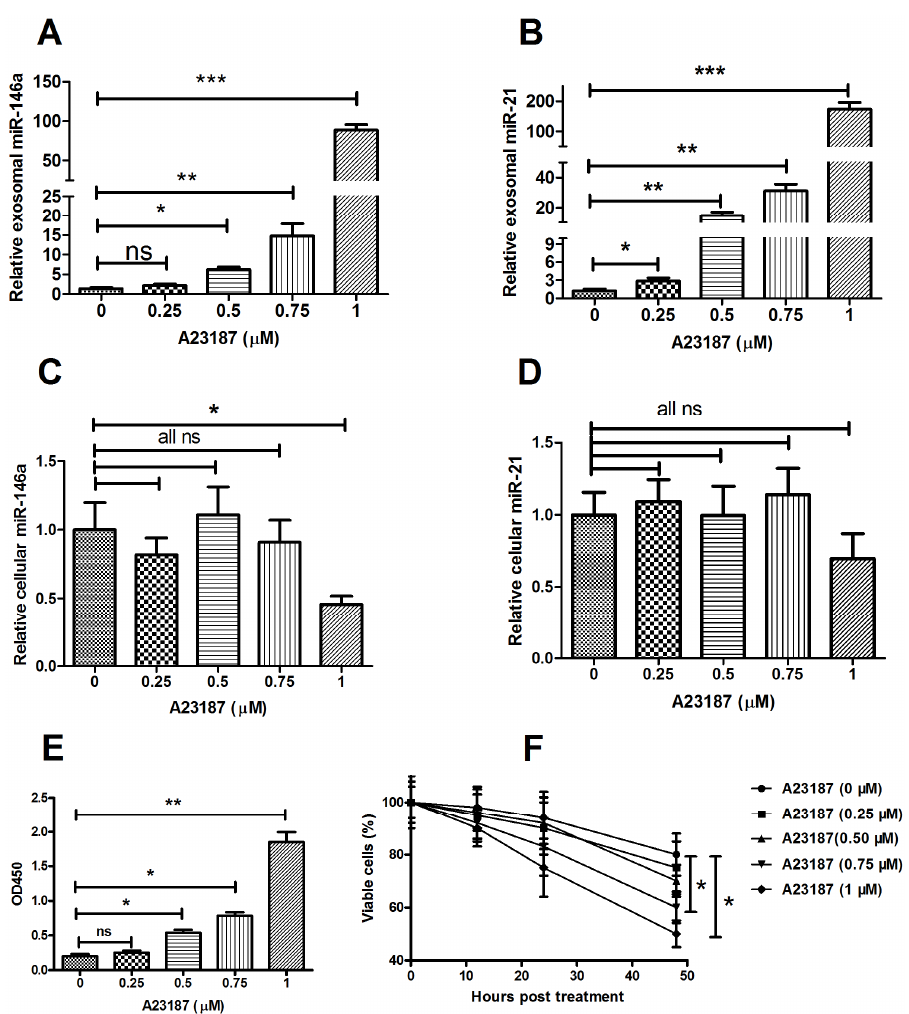
Figure 5. Calcium ionophore stimulated exosome secretion in Hela cells. ( A , B ) Relative expression levels of microRNA-146a ( A ) and microRNA-21 ( B ) in the exosomes released from Hela cells after the stimulation with various concentrations of A23187 for one hour; ( C , D ) Cellular microRNA-146a ( C ) and microRNA-21 ( D ) in Hela cells after the A23187 treatment for one hour; ( E ) Exosome were quantified by ELISA For CD9; ( F )Viability of the Hela cells after the A23187 treatment. All the exosome samples released from cells were quantified by the ELISA for CD9 before miRNA assay. In addition, all experiments were performed in triplicate. Statistical significance was considered with p < 0.05 ( *